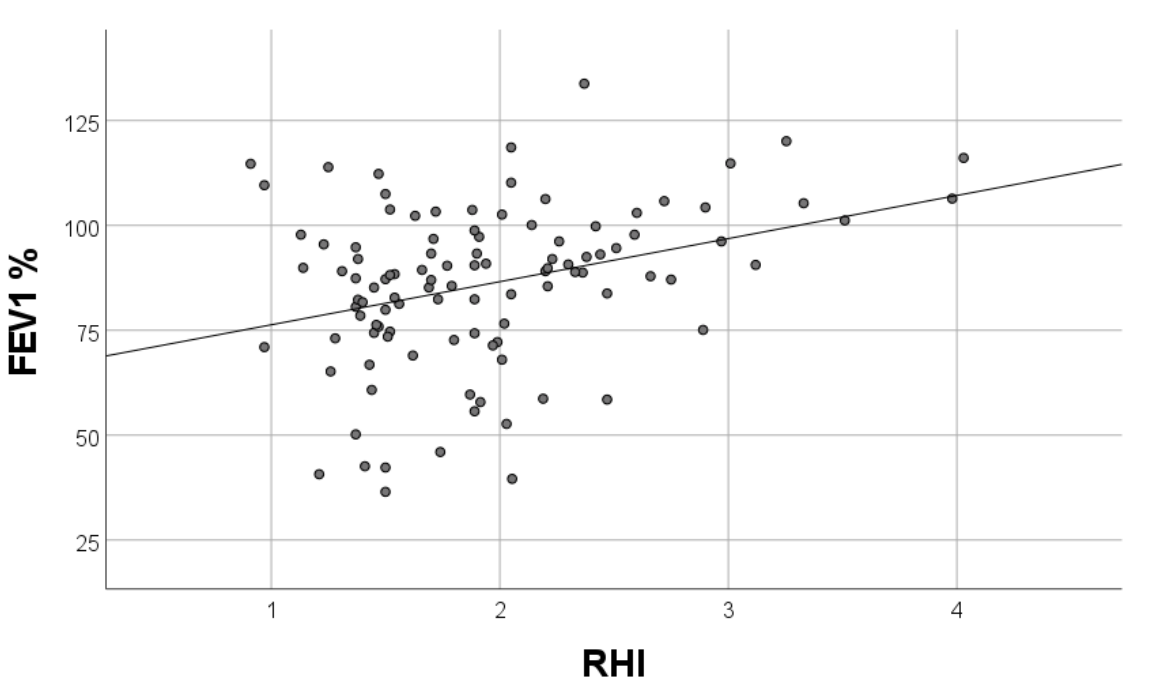
Figure 1. Correlation of forced expiratory volume in one second (FEV1%) and reactive hyperemia index values (RHI) R = 0.331; p = 0.001.